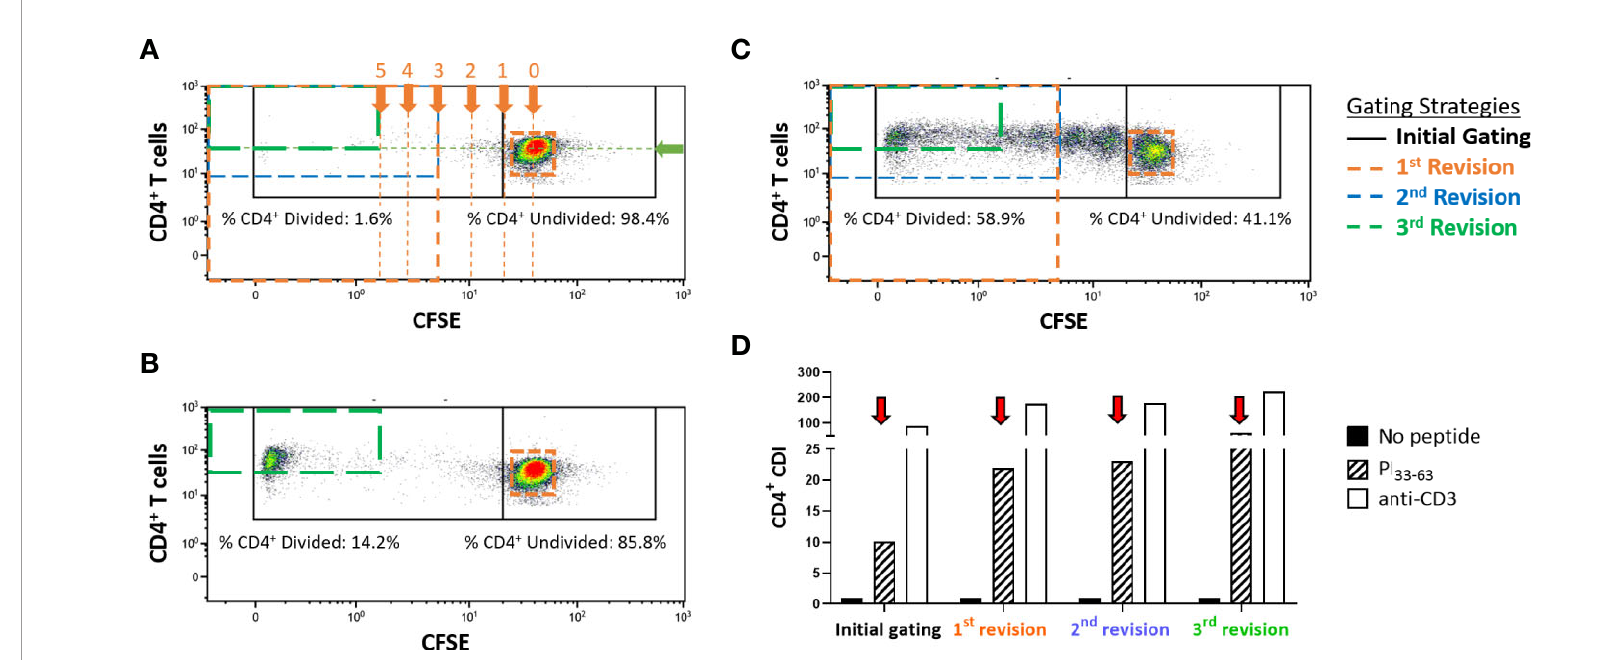
FIGURE 1 | Representative fl ow cytometry plots displaying gating strategies to assess CD4 + T-cell proliferative responses in freshly isolated PBMC measured with the CFSE proliferation assay after a 7-day incubation. Cells were fi rst gated on CD4 + CD3 + live single cells. (A) PBMC that were incubated without antigen (no-peptide negative control), (B) PBMC incubated with PI 33-63 , (C) PBMC incubated with anti-CD3 (positive control). Proliferating cells are gated (left gates). In this example, 14.21% of CD4 + T-cells divided in response to incubation with PI 33-63 when the 3 rd revised gating strategy was applied. Gates are set mathematically on the no-peptide condition and applied to all other conditions. The “ initial gating ” capturing the CFSE (undivided) cells on the right, and CFSE (divided) cells on the left is shown in black. The arrows labeled “ 0, 1, 2, 3, 4, 5 ” indicate the numbers of cell divisions, equivalent to MFI divided by 1, 2, 4, 8, 16, 32. The green arrow indicates the MFI of CD4, expressed by the CFSE (undivided) population. (D) Revised gating strategies reduced capture of the no-peptide background proliferation and resulted in a higher CDI for all antigen-stimulated conditions. CDI, Cell division